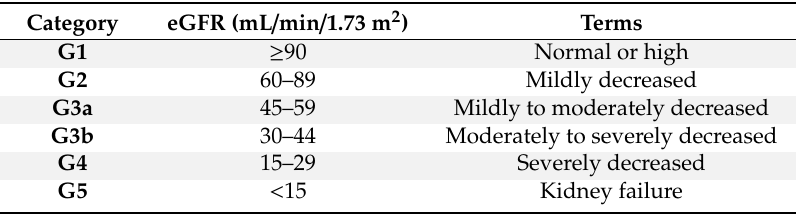
Table 1. Estimated glomerular filtration rate (eGFR) categories in CKD.